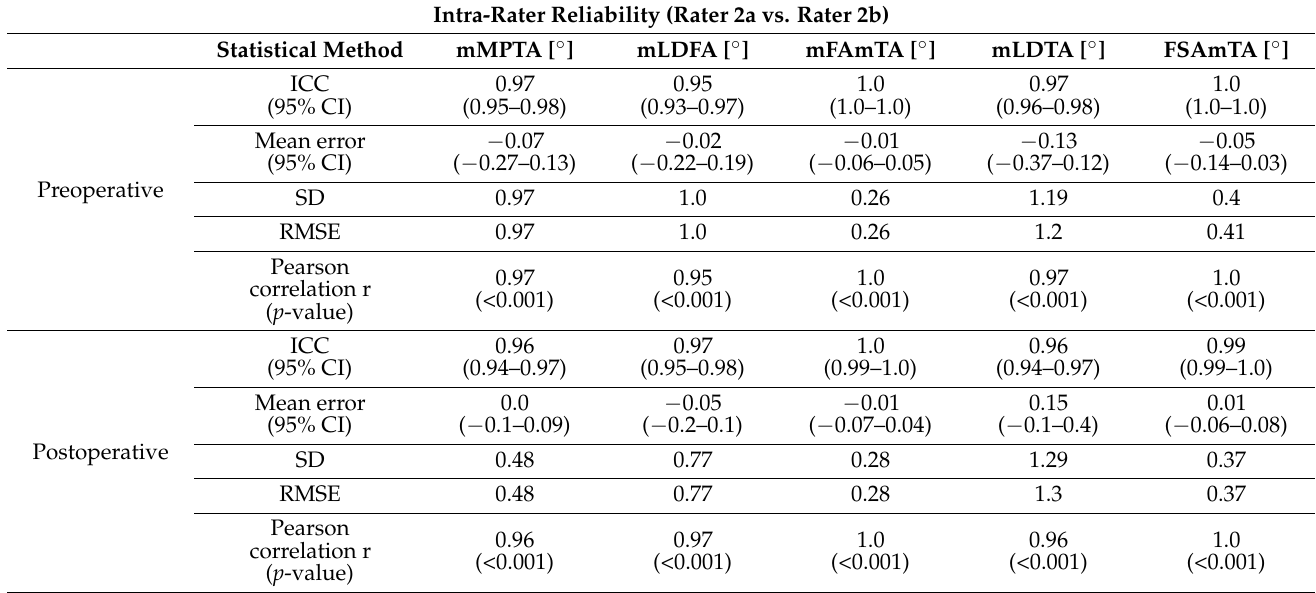
Table 1. Intra-rater reliability of the manual measurements; rater 2a vs rater 2b; preoperative n = 95, postoperative n = 105.